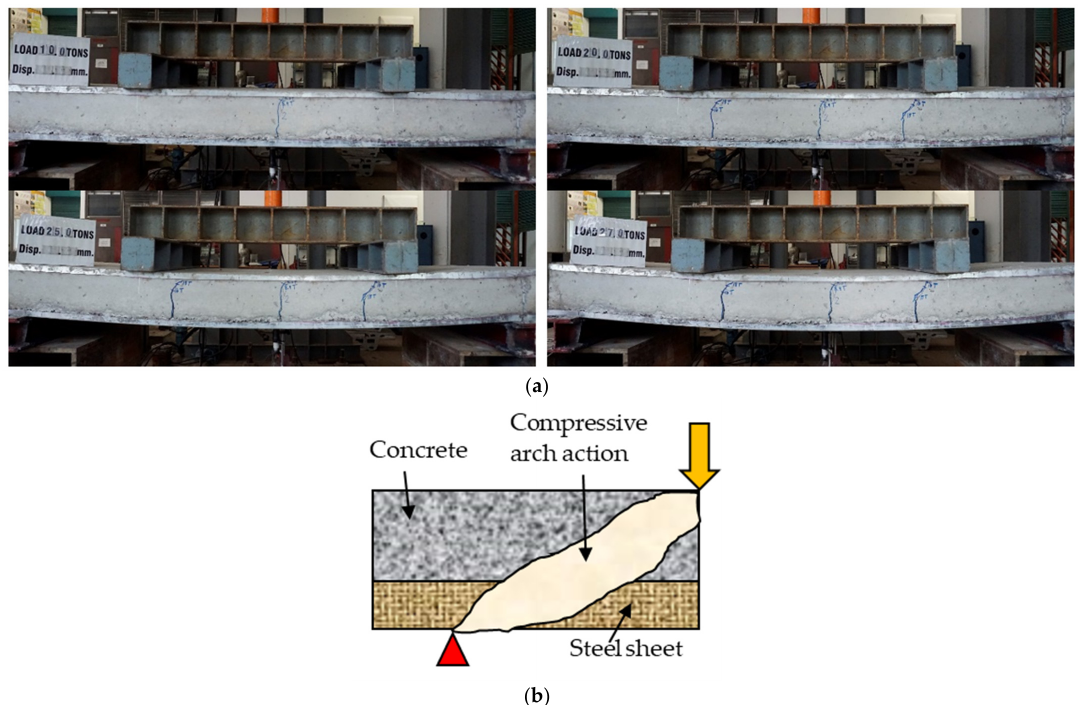
Figure 7. Crack mechanism of specimen S1: ( a ) crack progression; ( b ) demonstration of compressive arch action.